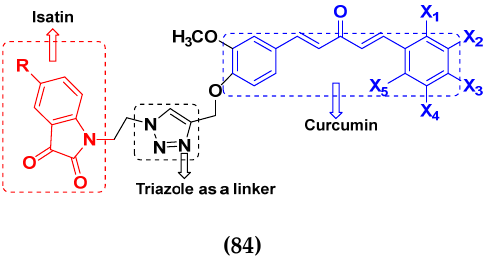
Figure 81. Structure of curcumin ‐ isatin derivatives ( 84 ). Table 70. In vitro cytotoxic activities of curcumin ‐ isatin hybrid compounds 84 ( a – c ). Compound No.